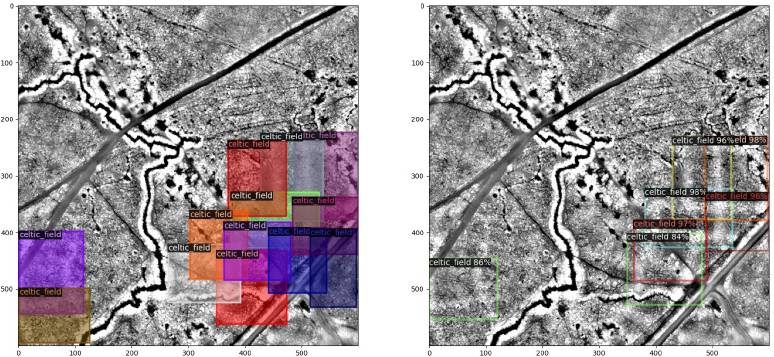
Figure 12. Celtic field ground truth ( left ) vs. prediction ( right ) obtained with the R_50_C4_3x model, showing a clear difference between the often overlapping, ground truth bounding boxes and the predicted bounding